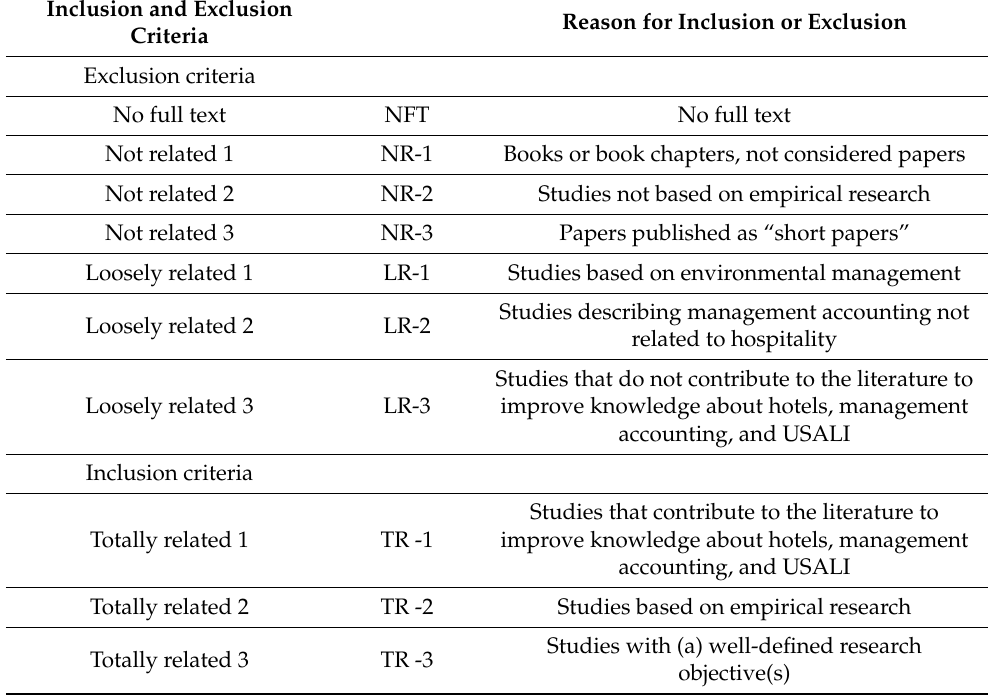
Table 1. Inclusion and exclusion